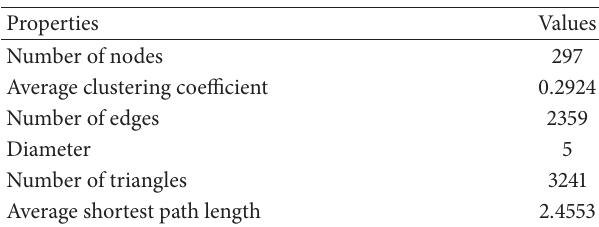
Table 1: Neural Network dataset properties.